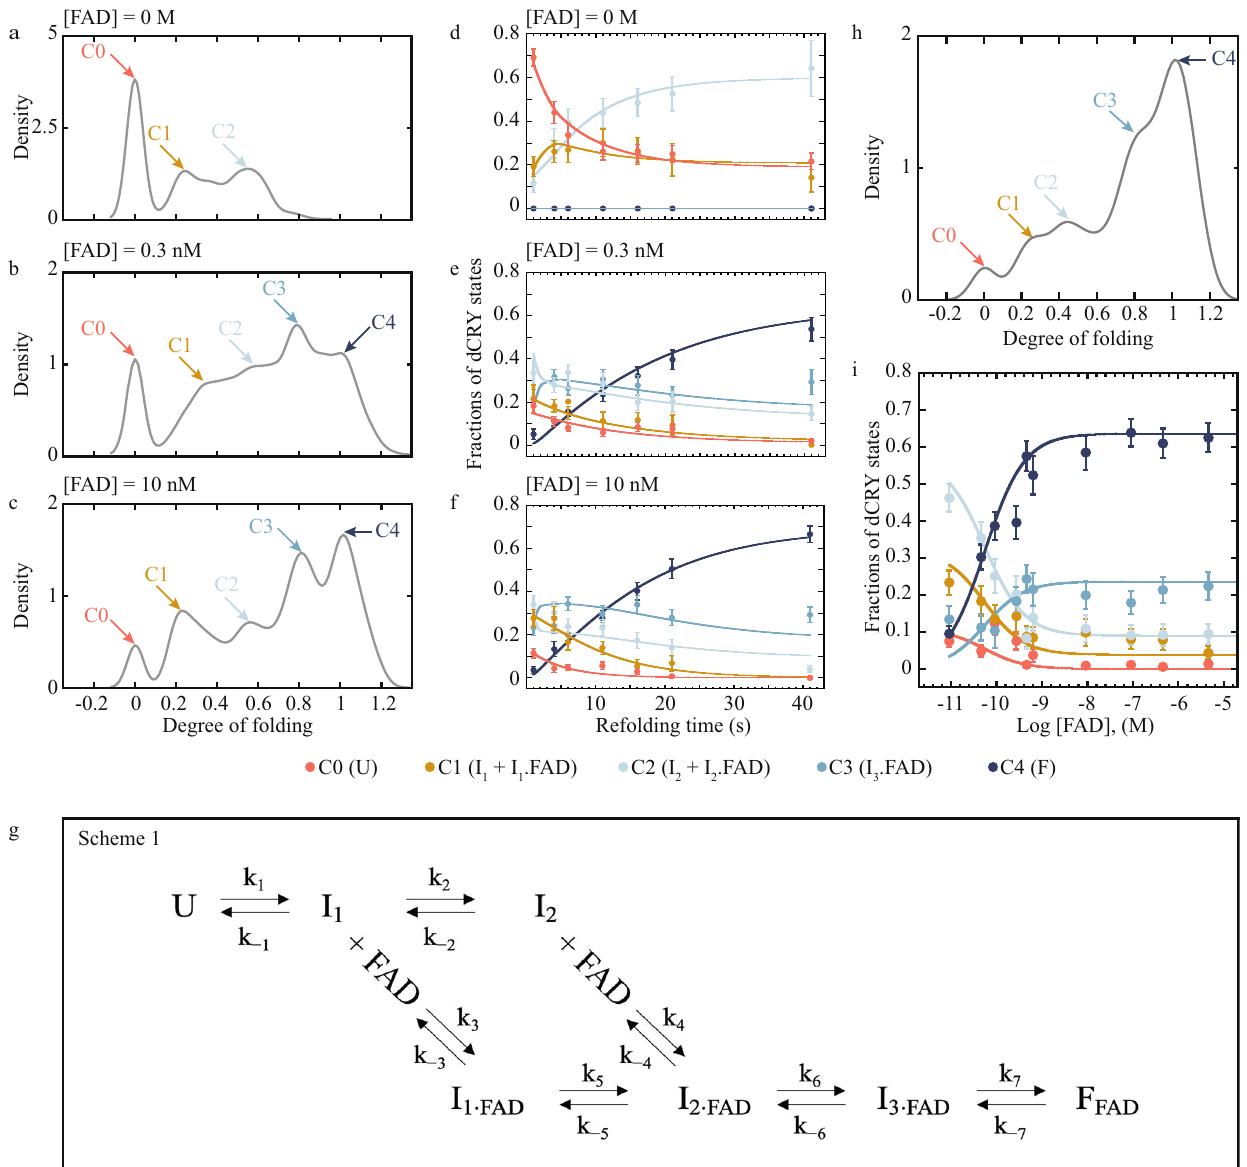
Fig. 3 | Kinetic analysis of FAD binding coupled to dCRY folding. a – c Density plots of degree of folding of combined data at [FAD]=0, 0.3nM and 10nM, respectively. The combined density plots reveal fi ve distinct clusters (labeled C0 thru C4) with degree of folding centered at 0, 0.26±0.01, 0.52±0.01, 0.80±0.01 and 1.0±0.01, respectively (Supplementary Table 1). d – f Plots of bootstrapped refolding data as a function of time at each FAD concentration. The data were globally fi tted following the mechanism shown in the scheme in ( g ). g Model of dCRY folding. h Density plotofcombined FAD titration data displays the same fi ve clustercentersasinthekineticrefoldingdatashownin( a – c ). i FADtitrationplotof clustered and bootstrapped data from FAD titration experiments. The solid lines